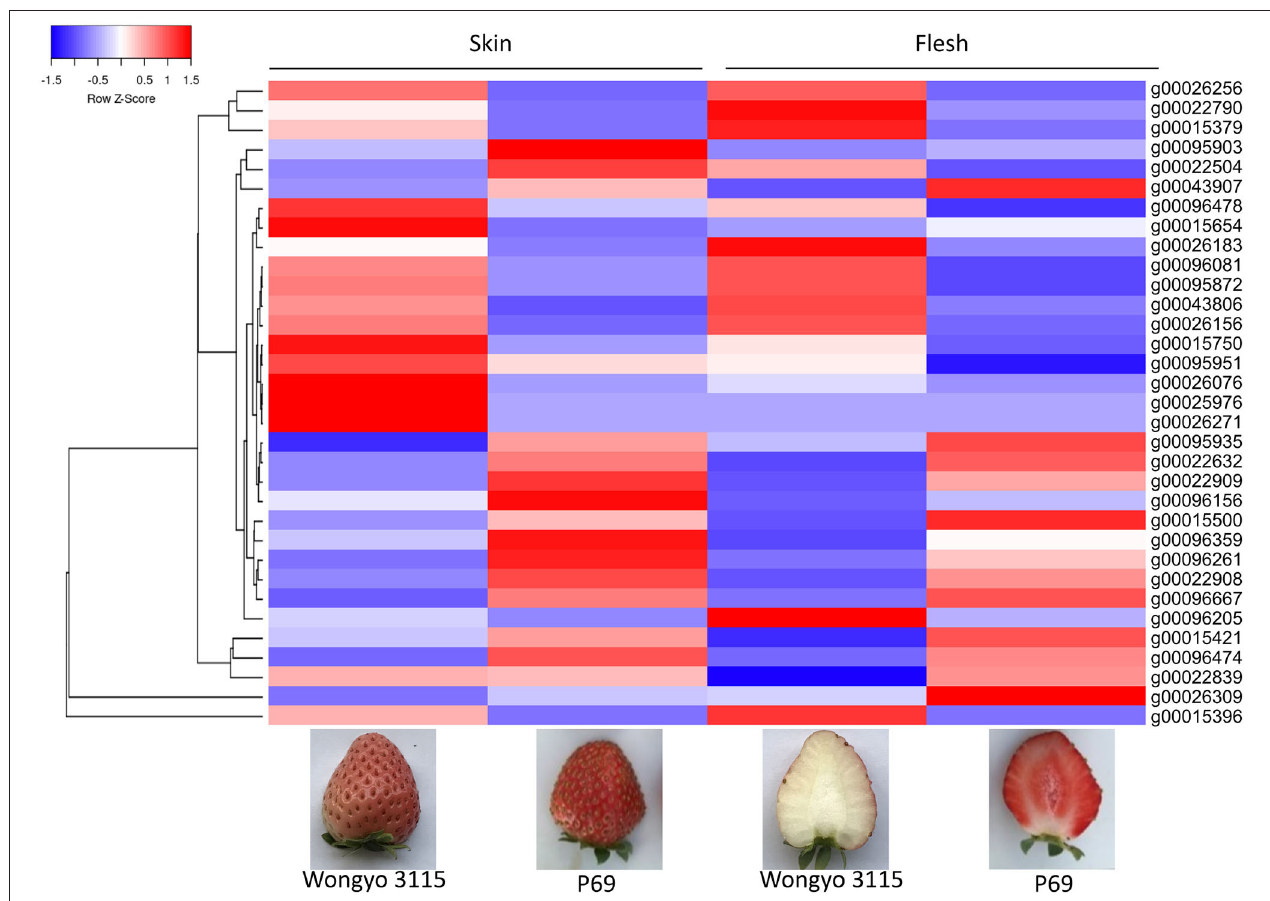
FIGURE 4 | Heat map representation of 33 differentially expressed predicted candidate genes associated with fruit